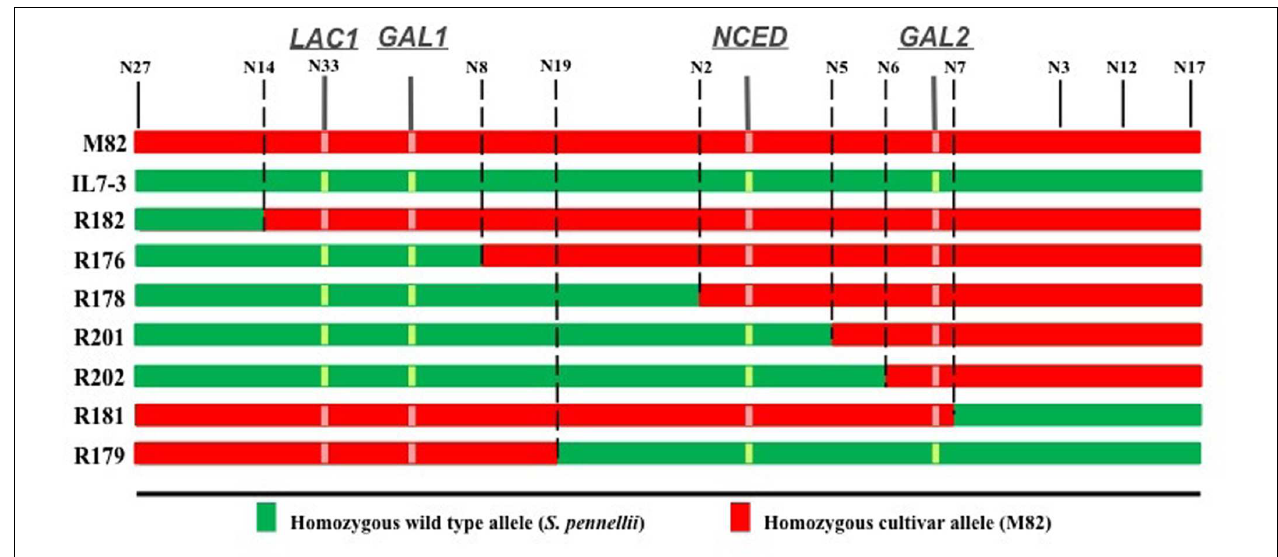
FIGURE 2 | Size and genomic identity of the seven sub-lines selected from the region 7-3. For each sub-line (coded R), the boundary edges are indicated by the CAPS markers (coded N) that separated the wild genomic region (in green) from the cultivated one (in red). The position of the four CGs ( LAC1 , GAL1 , NCED , GAL2 ) in the region 7-3 is also reported.